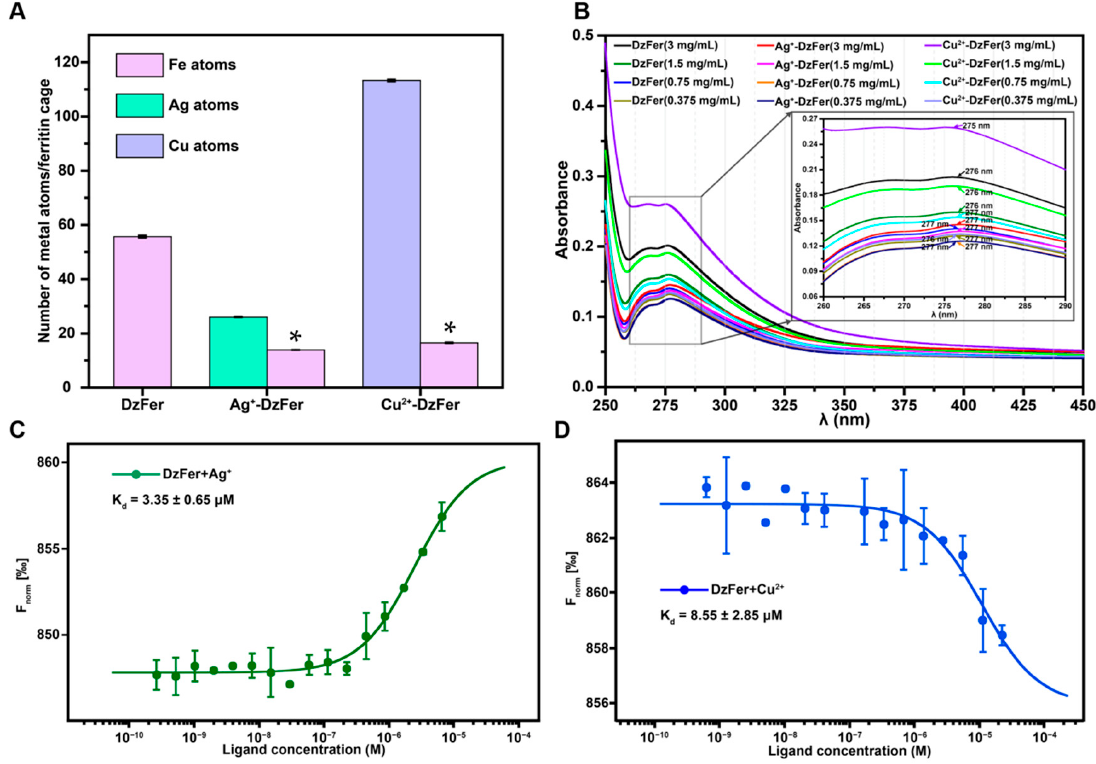
Figure 4. ( A ) Evaluation of the amount of Fe, Ag, and Cu atoms bound to the protein cage by ICP-MS. The protein concentrations were determined using a BCA kit. Data are represented as the mean ± standard error of the mean (SEM). The significant differences are indicated by * ( p < 0.05) as compared to the DzFer group. ( B ) UV–vis absorption spectra of DzFer, Ag + -DzFer, and Cu 2+ -DzFer proteins at the concentrations of 3, 1.5, 0.75, and 0.375 mg/mL, respectively. The inset (right) highlights the comparison of protein characteristic absorption peaks between 260 and 290 nm. Analysis of the interaction between DzFer and Ag + ( C ) or Cu 2+ ( D ) ions via microscale thermophoresis (MST). Error bars represent the range of data points obtained from three independent measurements.